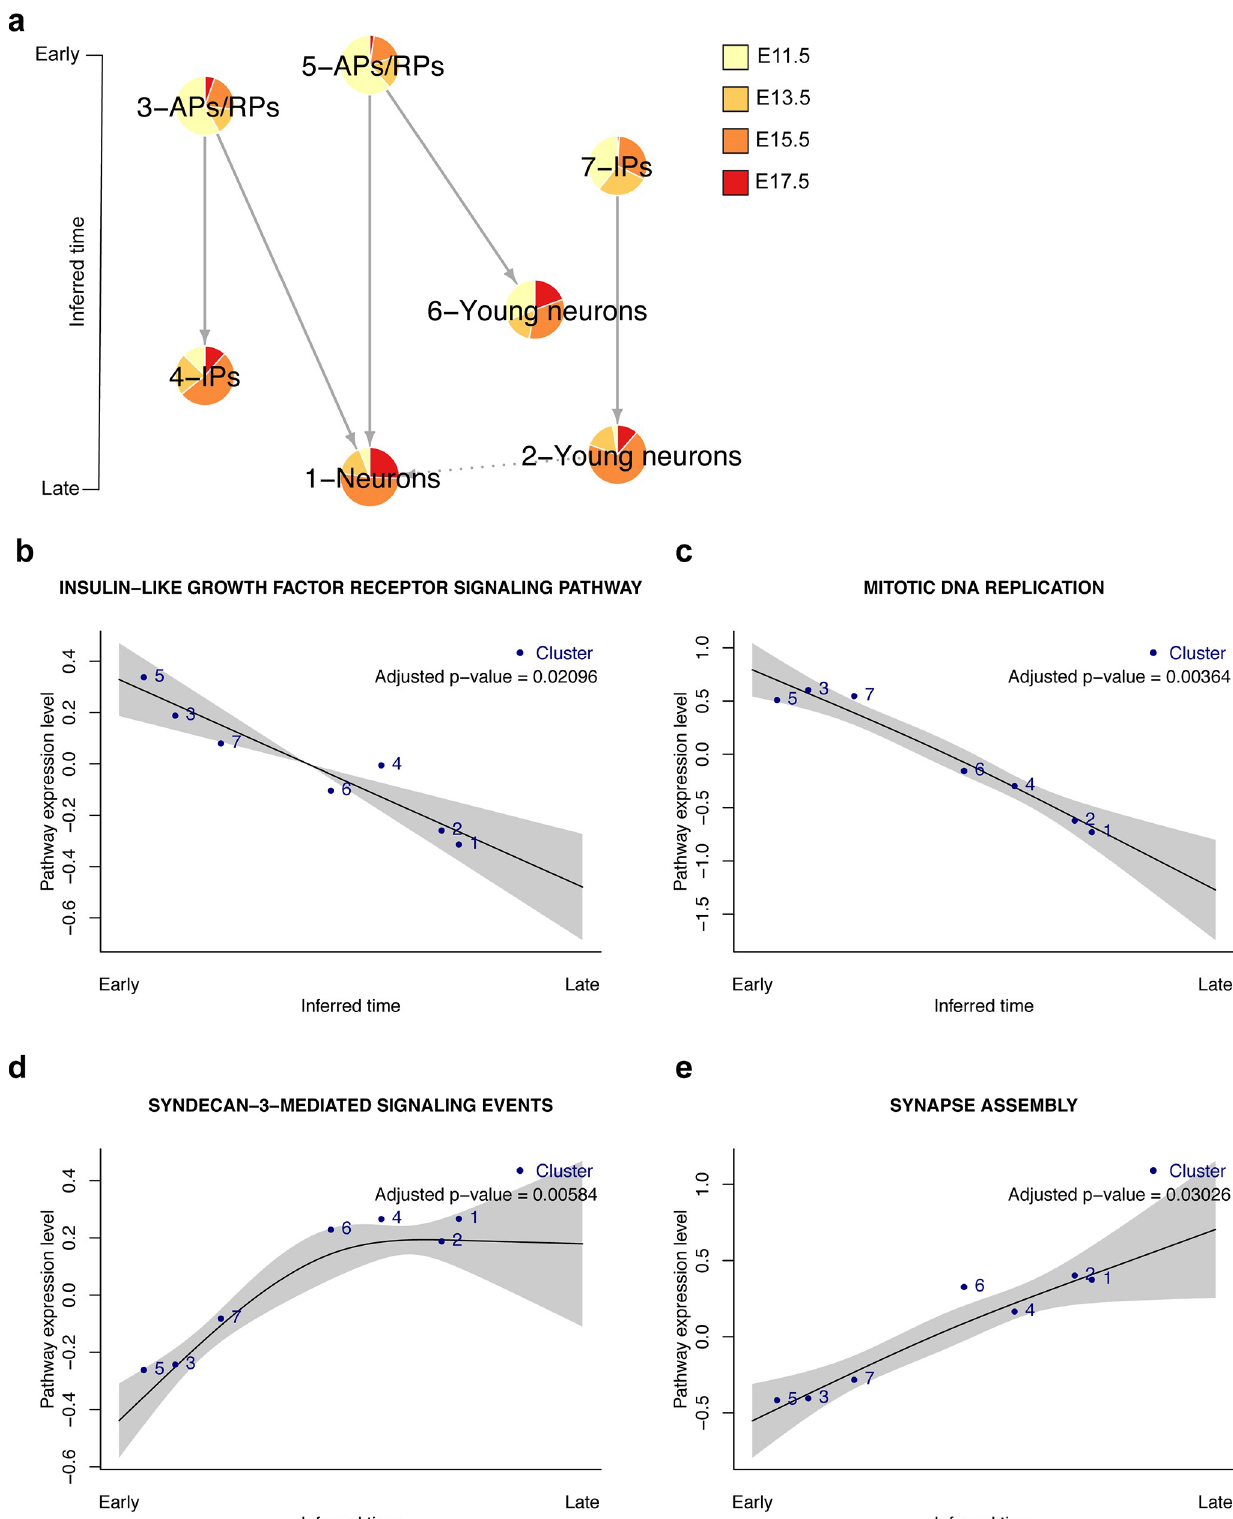
Fig 3. Tempora analysis of the murine cortex data set. a. Tempora trajectory built on clusters in the murine cerebral cortex data set. b-e. Time- dependent pathways in the murine cerebral cortex data set identified by Tempora’s pathway exploration feature. Blue dots represent clusters/cell types, the